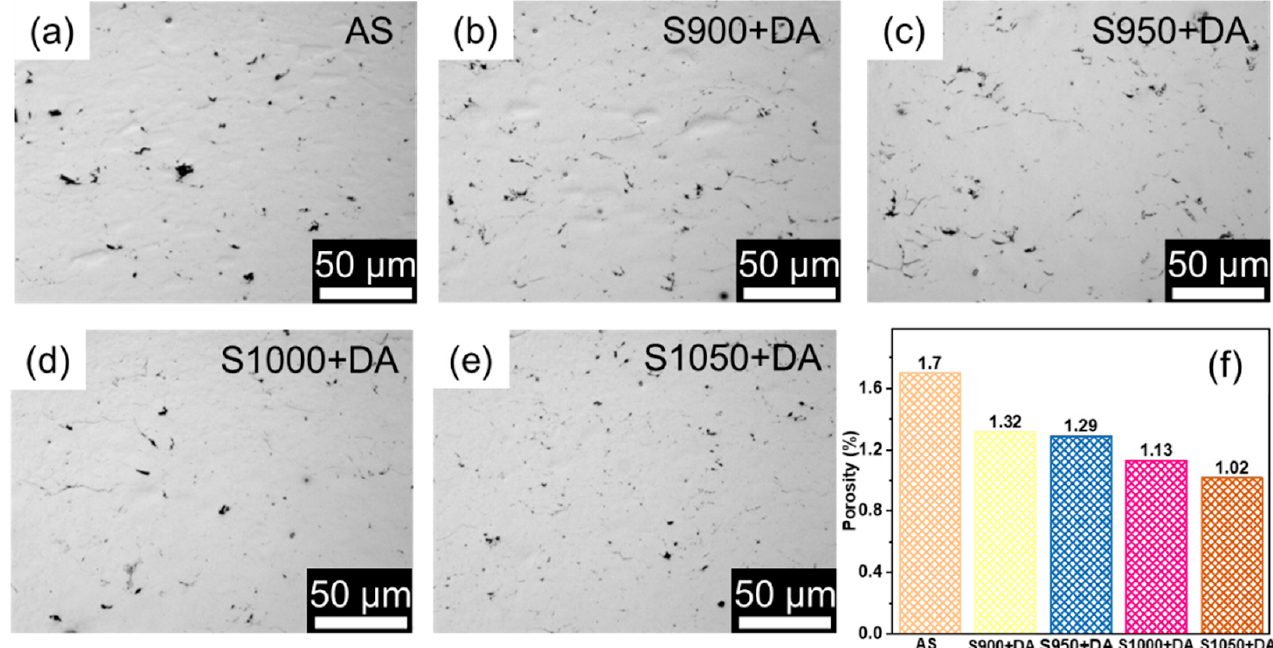
Figure 5. ( a – e ) Optical micrographs of cold sprayed IN718 coatings under different conditions: ( a ) as-sprayed, ( b ) S900 + DA, ( c ) S950 + DA, ( d ) S1000 + DA, and ( e ) S1050 + DA; ( f ) porosity levels of as-sprayed and heat-treated IN718 coatings.